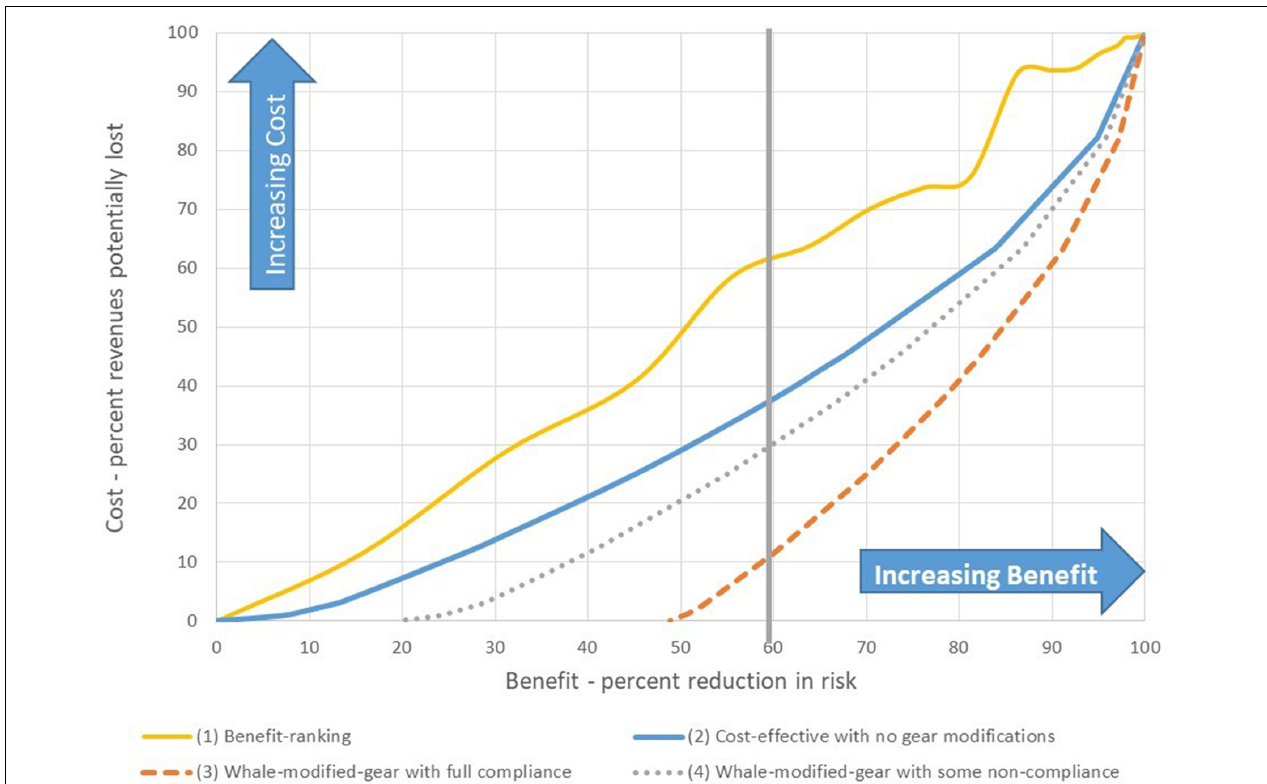
FIGURE 6 | Optimization results of trade-off between the non-monetary benefit of risk reduction and potential cost of closing months and areas (i.e., avoidance) along a continuum of no change (i.e., status quo, R = 0%) to a complete reduction in risk (i.e., complete closure, R = 100%). Scenarios ( Table 3 ) include: (1) benefit-ranking with no gear modifications, (2) cost-effectiveness with no gear modifications, (3) cost-effectiveness with whale-modified-gear requirements and full compliance, and, (4) cost-effectiveness with whale-modified-gear requirements and some